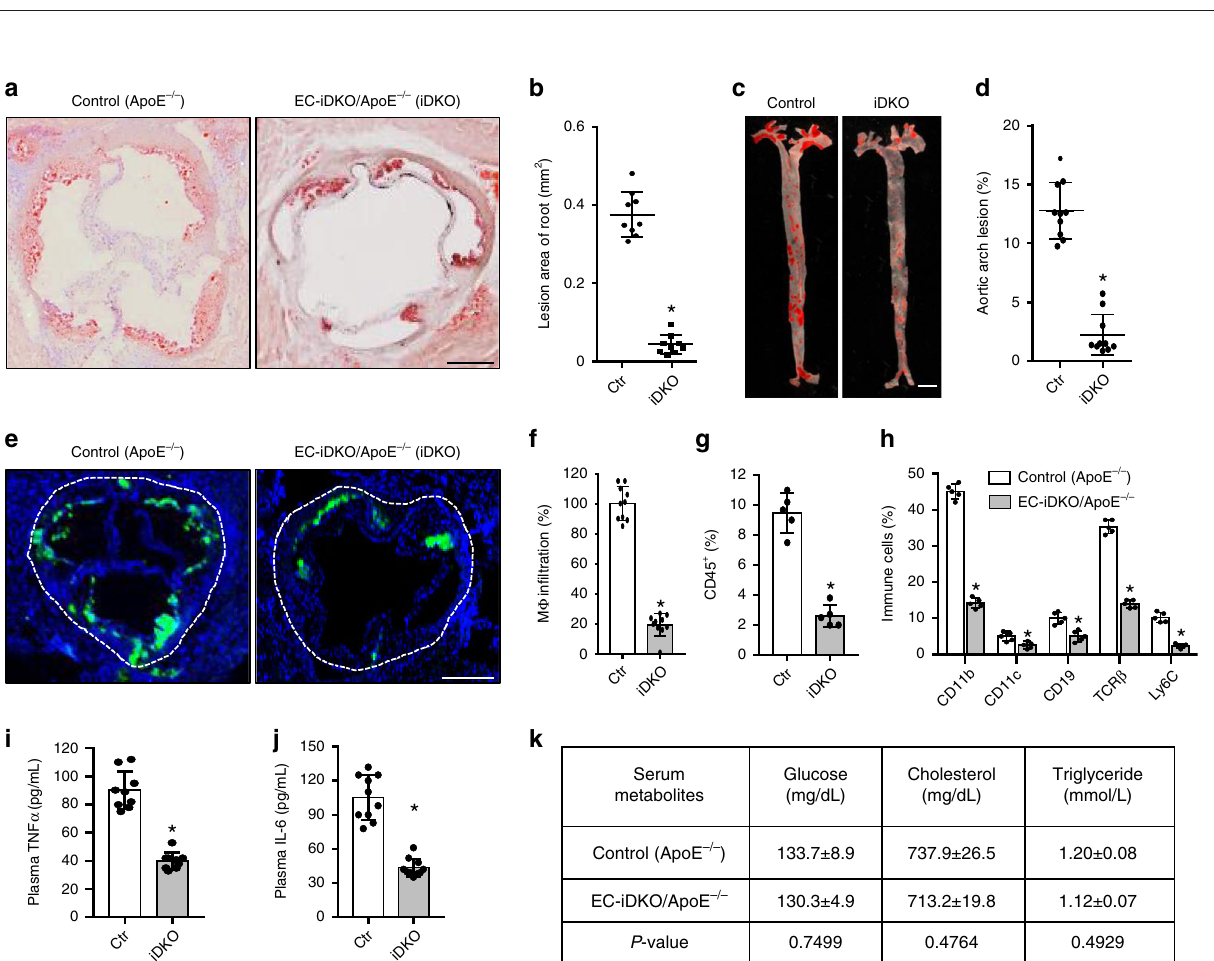
Fig. 4 Epsin de fi ciency maintains calcium homeostasis in atherogenic conditions and dampens in fl ammation in endothelial cells. a – c MAECs from control and iDKO mice were stimulated with ATP in the absence ( a ) or presence ( b ) of 100 µ g/mL oxLDL or 50 µ M 7-KC for 36 h and intracellular calcium was measured and quanti fi ed ( c ) ( n = 5 independent repeats, asterisk P < 0.001). d, e WT or iDKO MAECs were treated with 50 ng/ml TNF α for 3 h to detect P-selection or E-selectin for 16 h to detect adhesion molecules ICAM-1 and VCAM-1, as well as tubulin by western blot ( d ) prior to quanti fi cation ( e ) ( n = 5 ind e pendent repeats, asterisk P < 0.05). f, g WT and iDKO mice were injected with 0.5 µ g TNF α and sacri fi ced after 3 h (for P-selectin) or 16 h (for adhesion molecules). Heart sections were stained with antibodies for ICAM-1, VCAM-1, and P-selectin. Arrows indicate endothelial staining ( f ), which was quanti fi ed ( g ) ( n = 5 mice in each group, asterisk P < 0.001). Scale bar 100 µ m. h, i Neutrophil adhesion under fl ow (top panels) and static conditions (bottom panels) to TNF-treated MAECs isolated from WT and iDKO mice ( h ) and quanti fi cation ( i ) ( n = 3 independent repeats, asterisk P < 0.001). MAECs were isolated from Epsin 1 fl / fl /Epsin 2 − / − : VE-cadherin-Cre (top panels) or Epsin 1 fl / fl /Epsin 2 − / − : iCDH5-Cre mice (bottom panels). Scale bars 10 µ m (bright fi eld) or 200 µ m ( fl uorescence). j , k Peritoneal macrophage migration through con fl uent MAECs in the absence or presence of epsin 1 and 2 using a Transwell plate. LPS (200 ng/mL) or TNF α (50 ng/mL) was added to the upper Transwell chamber to stimulate endothelial cells for 3 h, followed by the addition of WT peritoneal macrophages ( j ). After 3 h, macrophages that migrated to the bottom of the Transwell chambers were subjected to enumeration and quanti fi cation (LPS and TNF α WT vs. iDKO, n = 3 independent experiments, and each treatment selected 3 fi elds for statistical analysis,